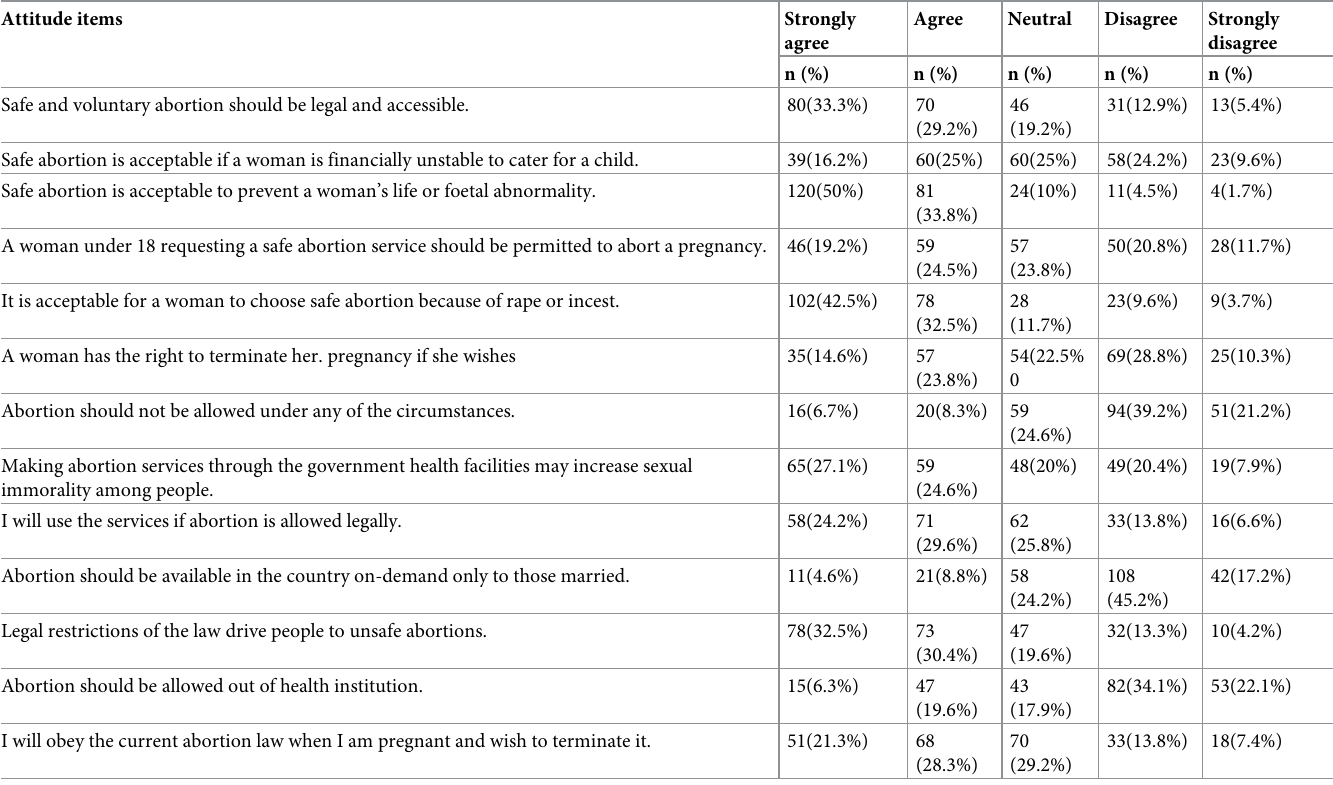
Table 4. Ghana’s abortion law-related attitudes of respondents (n = 240). Attitude